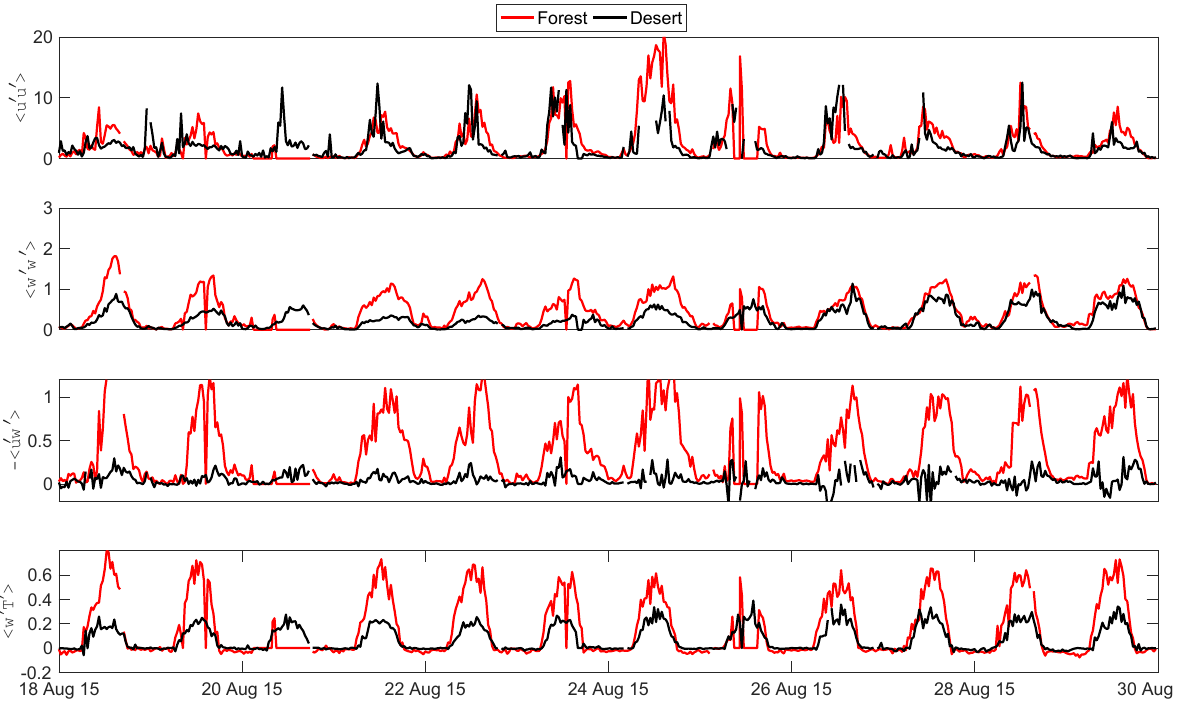
Figure 3. Time series of longitudinal velocity variance (m 2 s − 2 ), vertical velocity variance (m 2 s − 2 ), momentum flux (m 2 s − 2 ) and sensible heat flux (Kms − 1 ) for the measurement period. The black line indicates desert, and the red line indicates